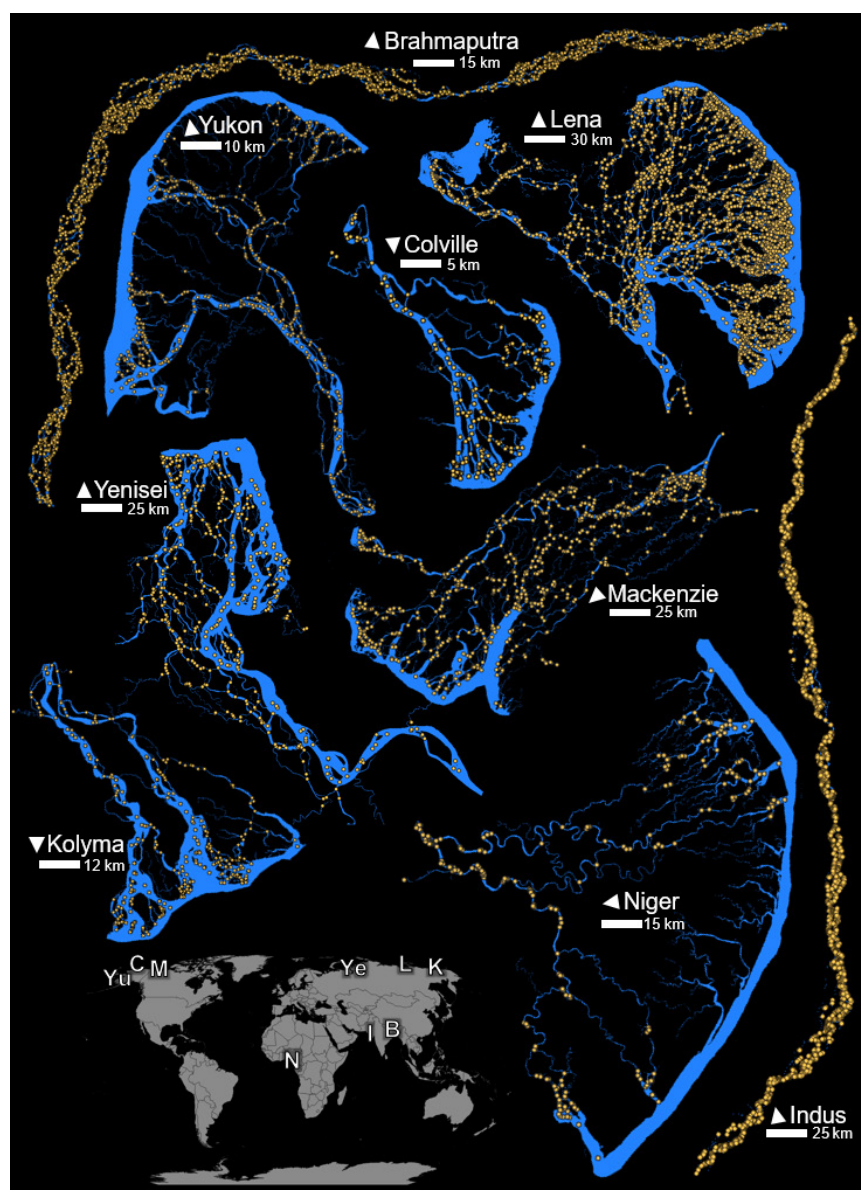
Figure 1. Study channel networks. Channel masks are blue, and nodes of the extracted networks are orange. Delta channel masks also include a portion of the ocean along the delta front. For clarity, links are not displayed but may be assumed between each pair of adjacent nodes. Locations of the (Yu) Yukon, (C) Colville, (M) Mackenzie, (Ye) Yenisei, (L) Lena, (K) Kolyma, and (N) Niger deltas as well as the (B) Brahmaputra and (I) Indus rivers are shown on the map of continents. Arrows for each point